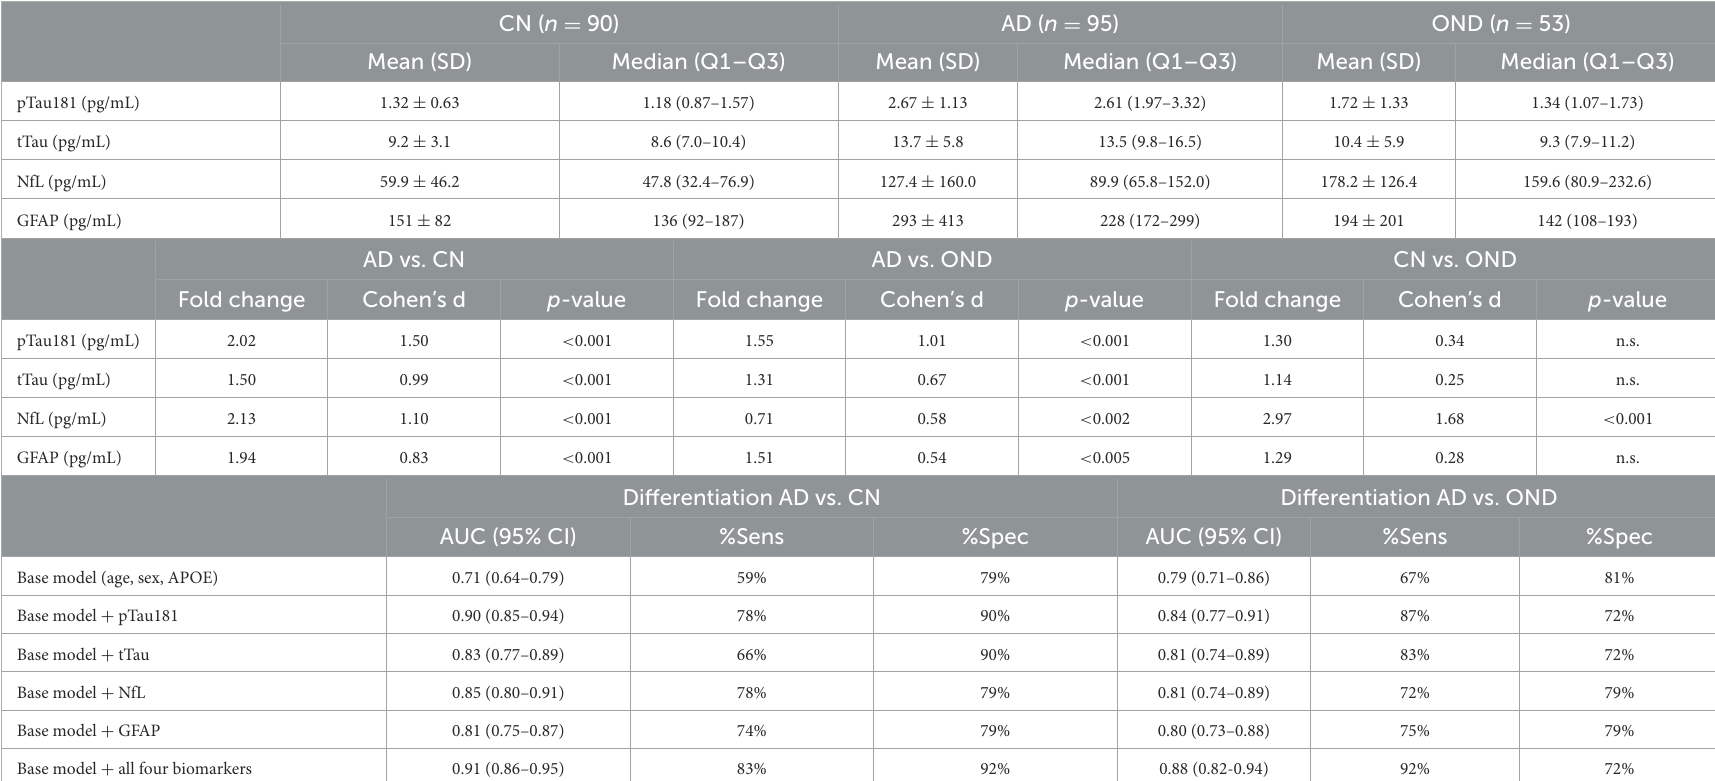
TABLE 4 Clinical performance of the four biomarker assays in Sample B (“High contrast” diagnostic